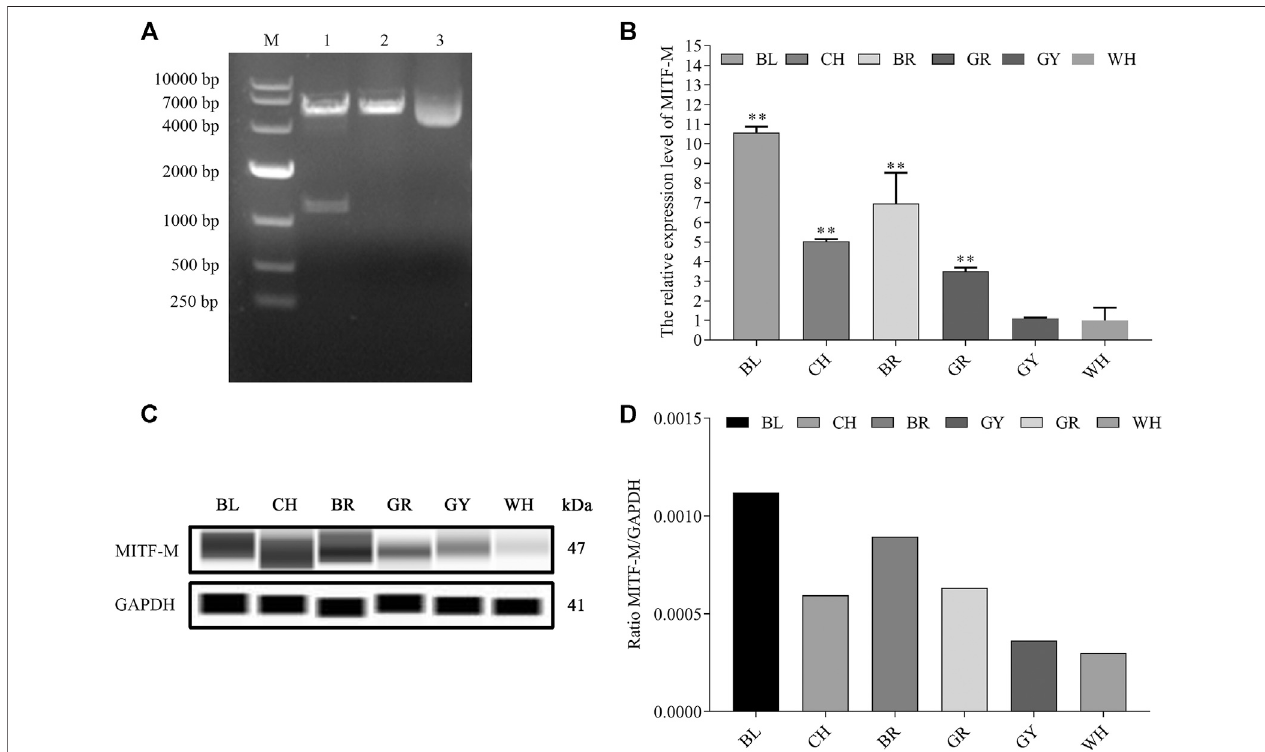
FIGURE 1 | The mRNA and protein expression levels of MITF-M in rabbit skin with different coat colors. (A) The rabbit MITF-M cDNA was successfully cloned and reconstructed into pcDNA3.1-Flag vectors. M, DL10000 DNA Marker. Lane 1, pcDNA3.1(+)-Flag-MITF-M plasmid was digested by restriction enzymes Hind III and EcoR I. Lane 2, pcDNA3.1(+)-Flag-MITF-M plasmid wasdigested by restriction enzymes Hind III. Lane 3, pcDNA3.1(+)-Flag-MITF-M plasmid was not digested. (B) The MITF-MmRNAlevelinrabbitskinwithdifferentcoatcolorswasdeterminedthroughqRT-PCR.Eachsamplehadthreereplicates,andtherelativeexpressionlevels ofgenesweredeterminedusingGAPDHasaninternalcontrolbyusingthe2 − ΔΔ Ct method.Thesigni fi cantdifferencesamongthestudiedgroupswereanalyzedbyusing the white rabbit ’ skin as the control group, the fold change of other studied groups was calculated by the expression level of the white rabbit ’ skin was normalized to 1. Each group is an independent group. Least — Signi fi cant Difference (LSD) was employed to compare the studied groups to the control group. ** indicates p < 0.01. (C) The MITF-M protein expression in rabbit skin with different coat colors. (D) MITF-M protein differential expression trend in Rex rabbits with different coat colors. The relative expression ratio of MITF-M/GAPDH was quanti fi ed by the area of Wes. BL, black; CH, chinchilla; BR, brown; GR, gray; GY, gray-yellow; WH, white.